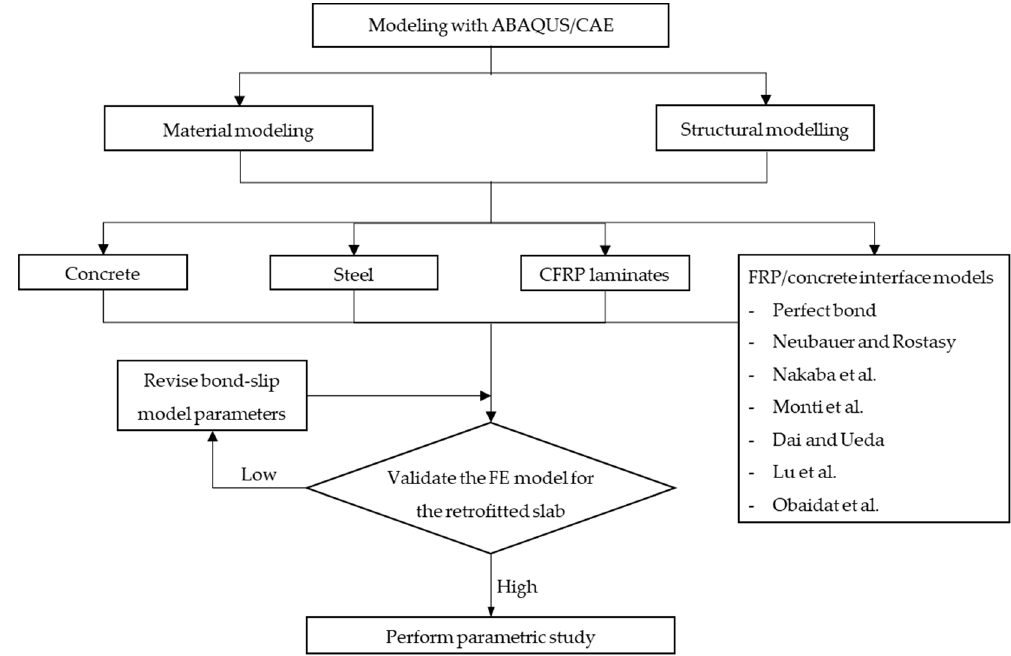
Figure 8. FE model analysis flowchart.